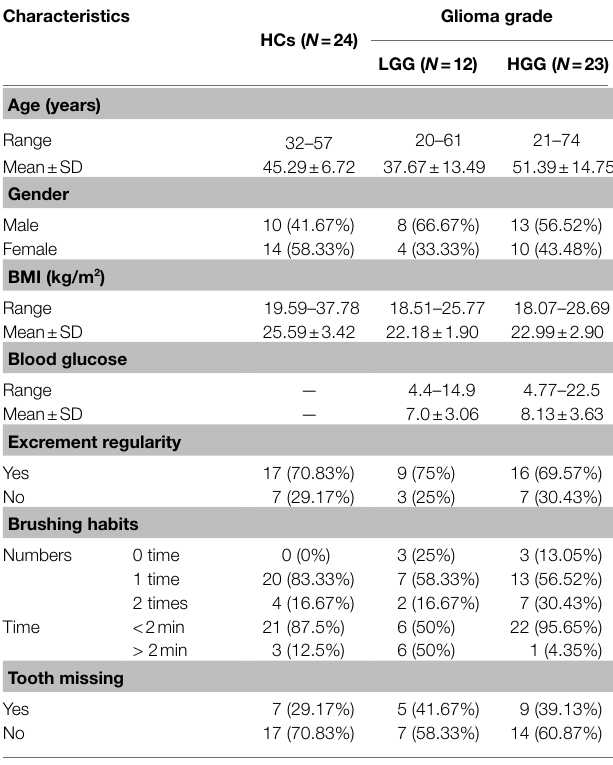
TABLE 1 | Clinical characteristics of the study population in this